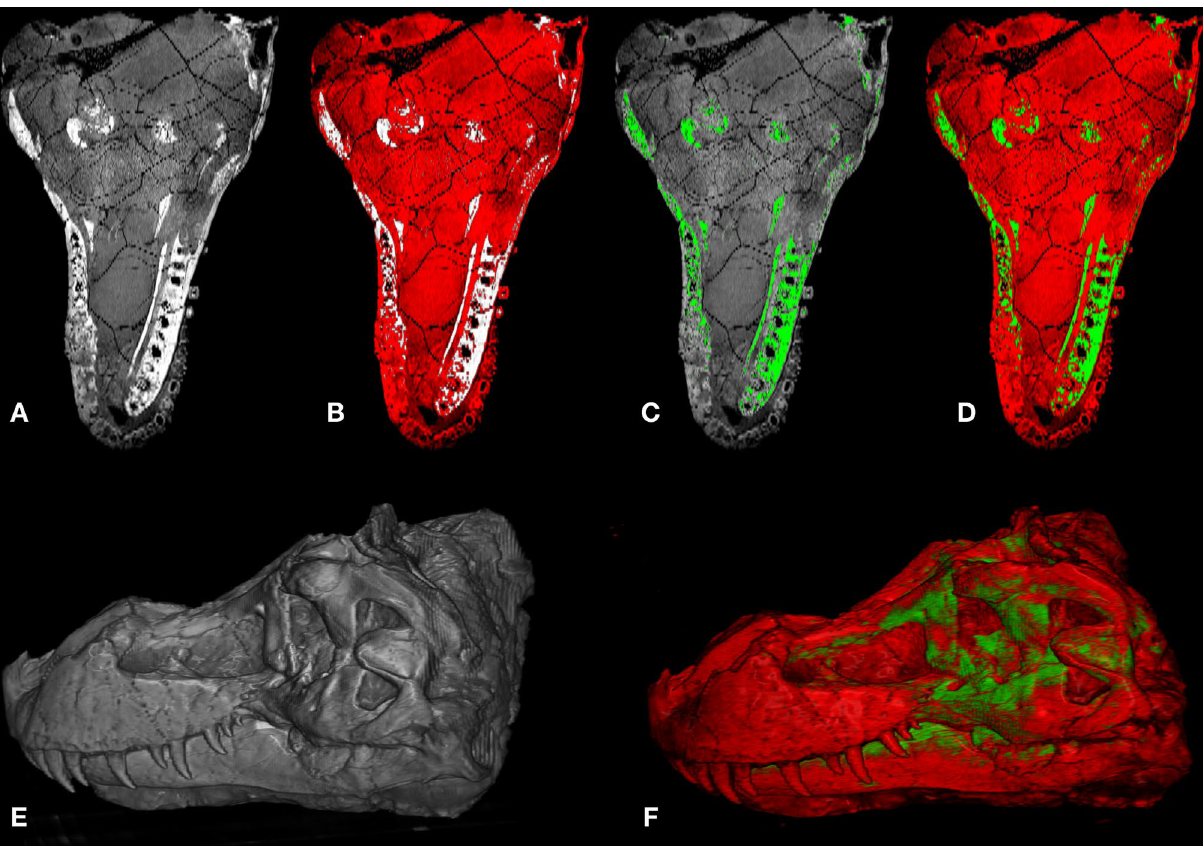
Figure 6. Automated shape analysis and segmentation of Tyrannosaurus Sue skull. ( A ) Slice through original CT volumetric data; ( B ) SWD of low intensity values, ( C ) SWD of high intensity values; ( D ) combined display of ( B , C ); ( E ) unsegmented SWD reconstruction of entire volume, ( F ) combined segmented SWD